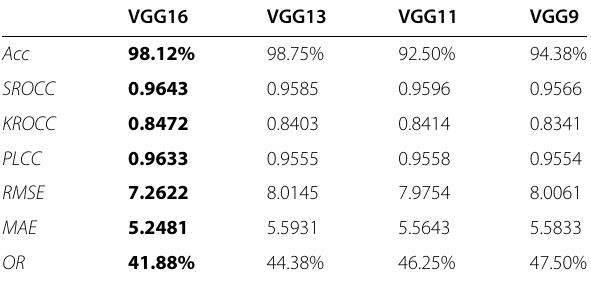
Table 11 Comparison of VGGNet degrading